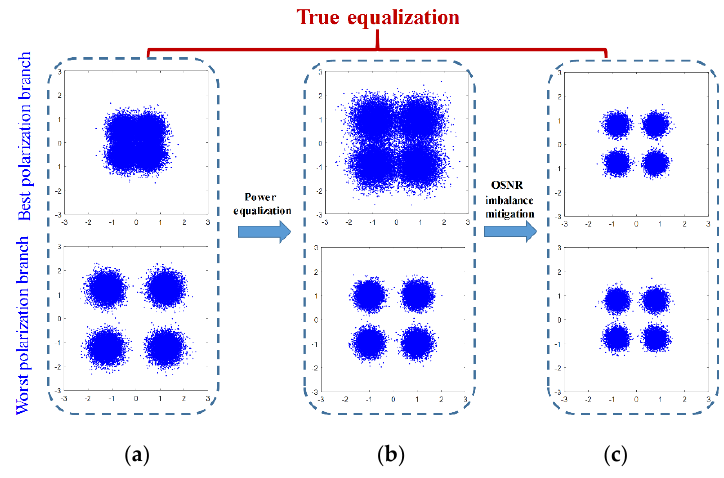
Figure 2. Schematic representation of PDL equalization: ( a ) The signal suffers PDL; ( b ) after power equalization; ( c ) after bit-error-rate (BER) recovery coming from optical signal-to-noise ratio (OSNR) imbalance.